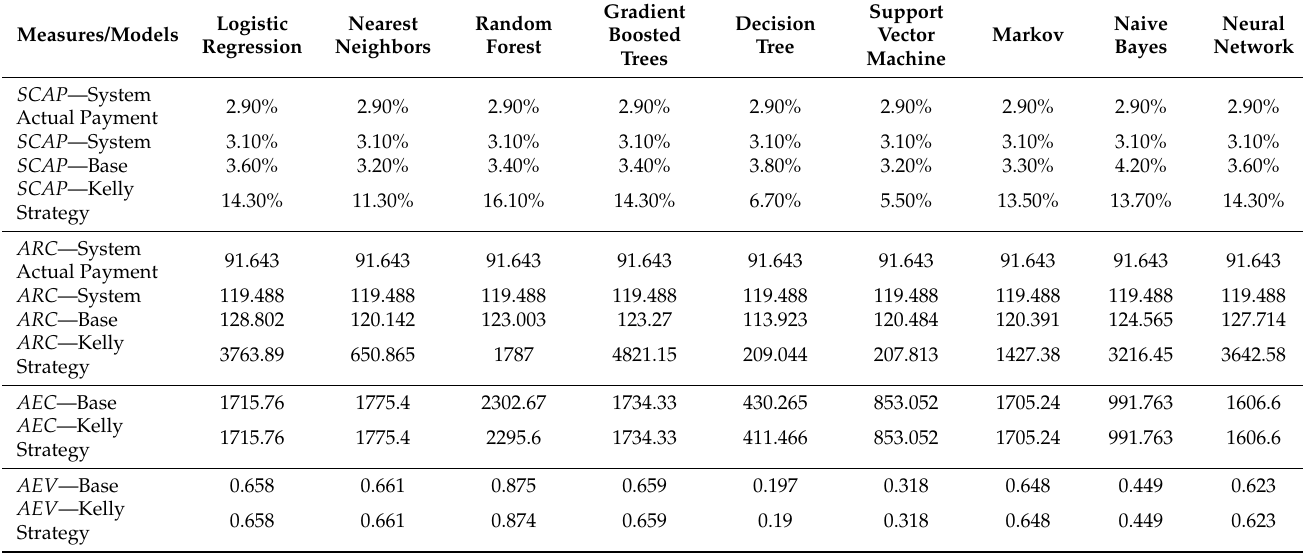
Table 3. Capital allocation performance.